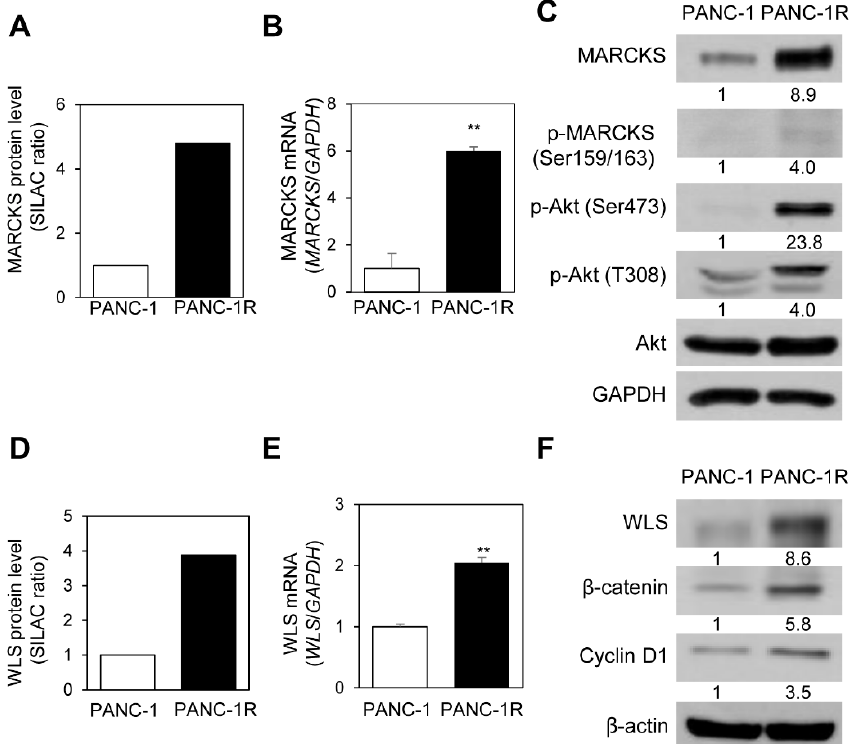
Figure 6. Myristoylated alanine-rich C-kinase substrate (MARCKS)- or Wntless homolog protein (WLS)-mediated downstream signaling is activated in PANC-1R cells. ( A ) The SILAC ratio of MARCKS was increased in PANC-1R cells. ( B ) The quantitative level of MARCKS mRNA by qRT-PCR was higher in PANC-1R cells. Three independent experiments were performed in triplicates. ( C ) The protein level of MARCKS, phospho-MARCKS (Ser159/163), phospho-Akt (Ser473 or Thr308), and total Akt was determined by Western blotting. GAPDH was used as a loading control. Full-length Western blot images are presented in Supplementary Figure S2. ( D ) The SILAC ratio of WLS was increased in PANC-1R cells. ( E ) The level of WLS mRNA by qRT-PCR was higher in PANC-1R cells. Three independent experiments were performed in triplicate. ( F ) The protein level of WLS, β -catenin, and cyclin D1 was determined by Western blotting. β -actin was used as a loading control. ** p < 0.01. Full-length Western blot images are presented in Supplementary Figure S2.